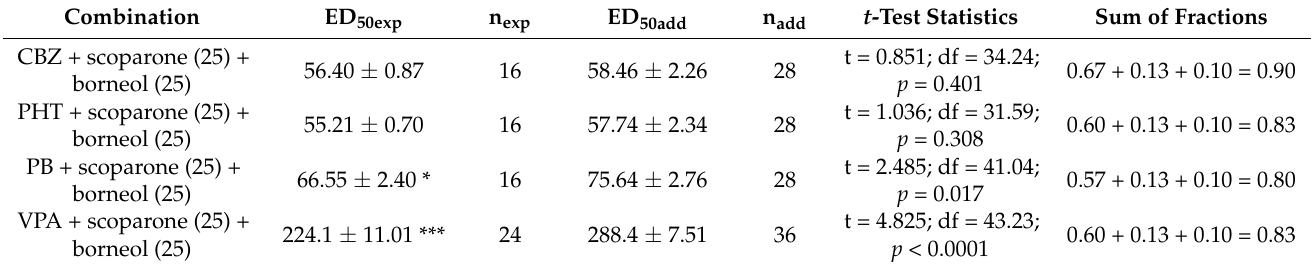
Table 3. Isobolographic transformation of the anticonvulsant potency of three-drug combination— scoparone, borneol and four classic antiseizure medications in the mouse MES model.